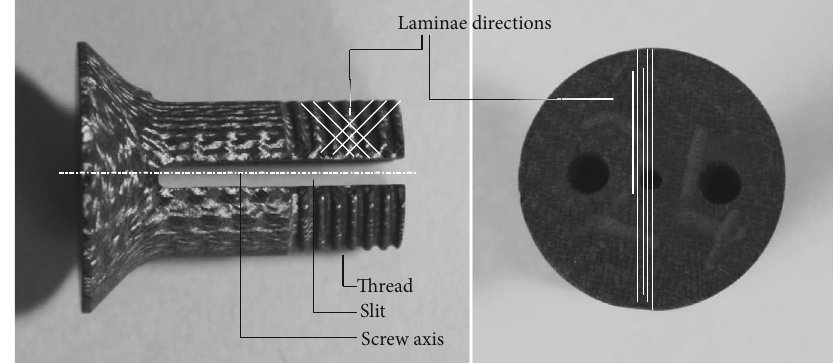
Figure 6: Fastener side and top views [30].